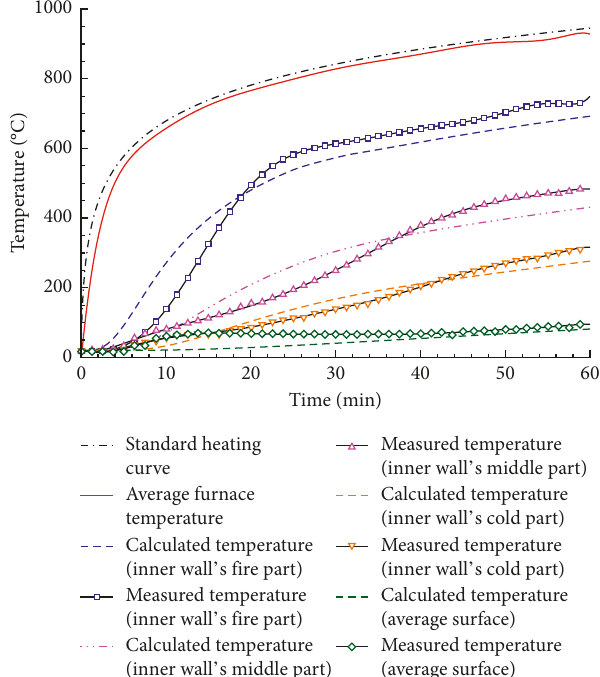
Figure 12: Measured temperatures compared to the calculated values in Test 1.